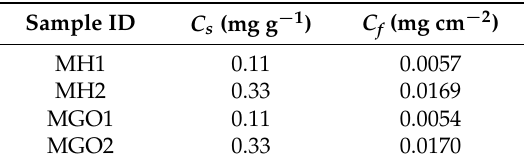
Table 1. MGO concentration in either the coating solutions ( C s ) or resulting coated nonwoven fabrics ( C f